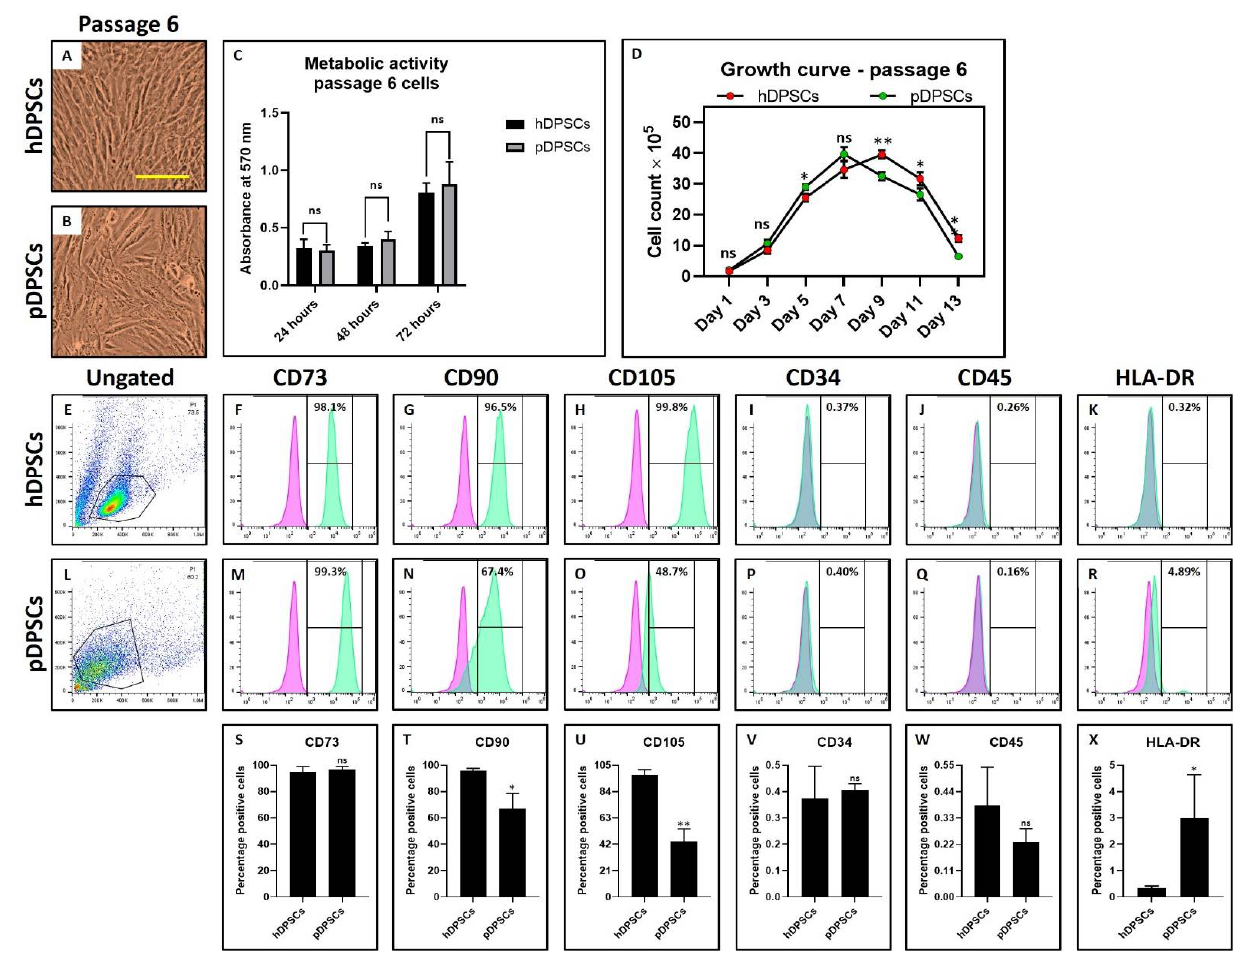
Figure 3. Assessment of morphology, metabolic activity, and MSC markers in DPSCs from healthy and periodontitis- affected teeth at Passage 6. ( A , B ) photomicrograph showing the morphology of hDPSCs and pDPSCs at Passage 6. Scale bar = 100 µm. ( C ) comparative analysis of the metabolic activity in hDPSCs and pDPSCs at 24, 48 an 72 h. ( D ) comparative analysis of cellular growth in hDPSCs and pDPSCs. ( E – X ) comparative analysis of MSC-specific cell surface maker analysis for CD73, CD90, CD105, CD34, CD45 and HLA-DR in hDPSCs and pDPSCs. Experiments were repeated in triplicates for n = 3. ns: not significant, * p < 0.05 and ** p < 0.01. hDPSCs: dental pulp stem cells from healthy teeth and pDPSCs: dental pulp stem cells from periodontitis-affected teeth.